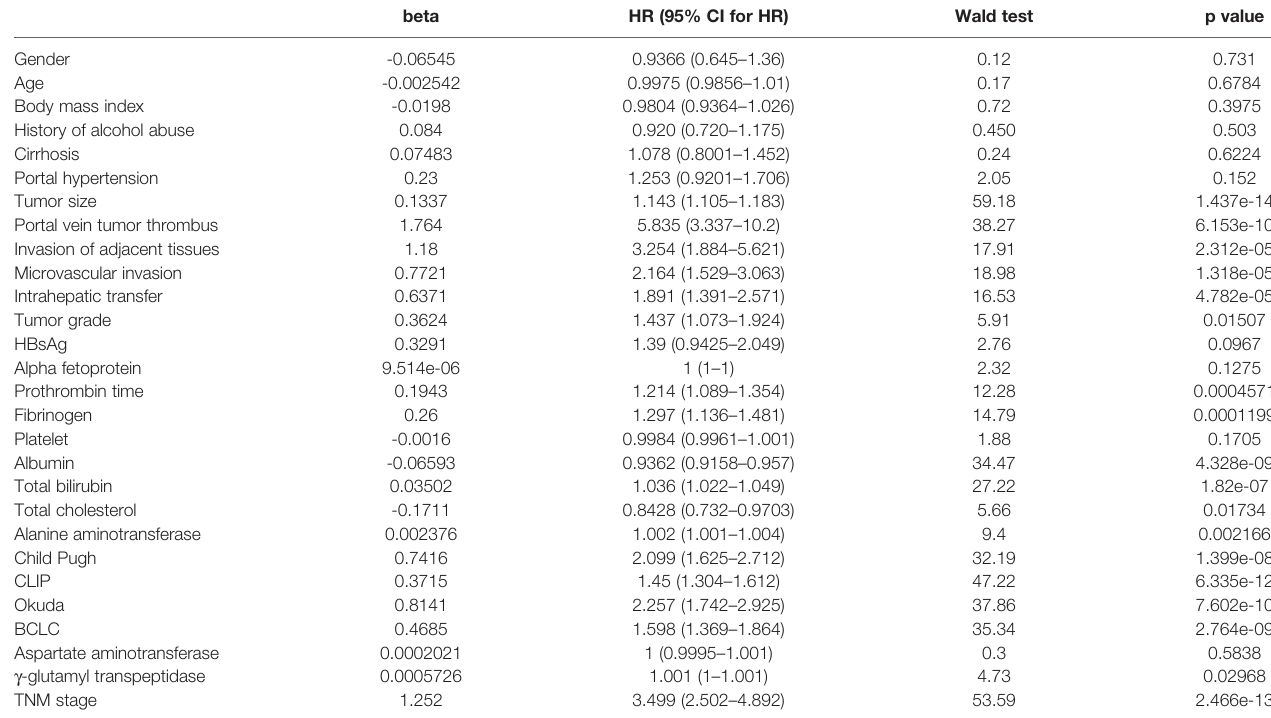
TABLE 2 | Univariate analysis of the training cohort.